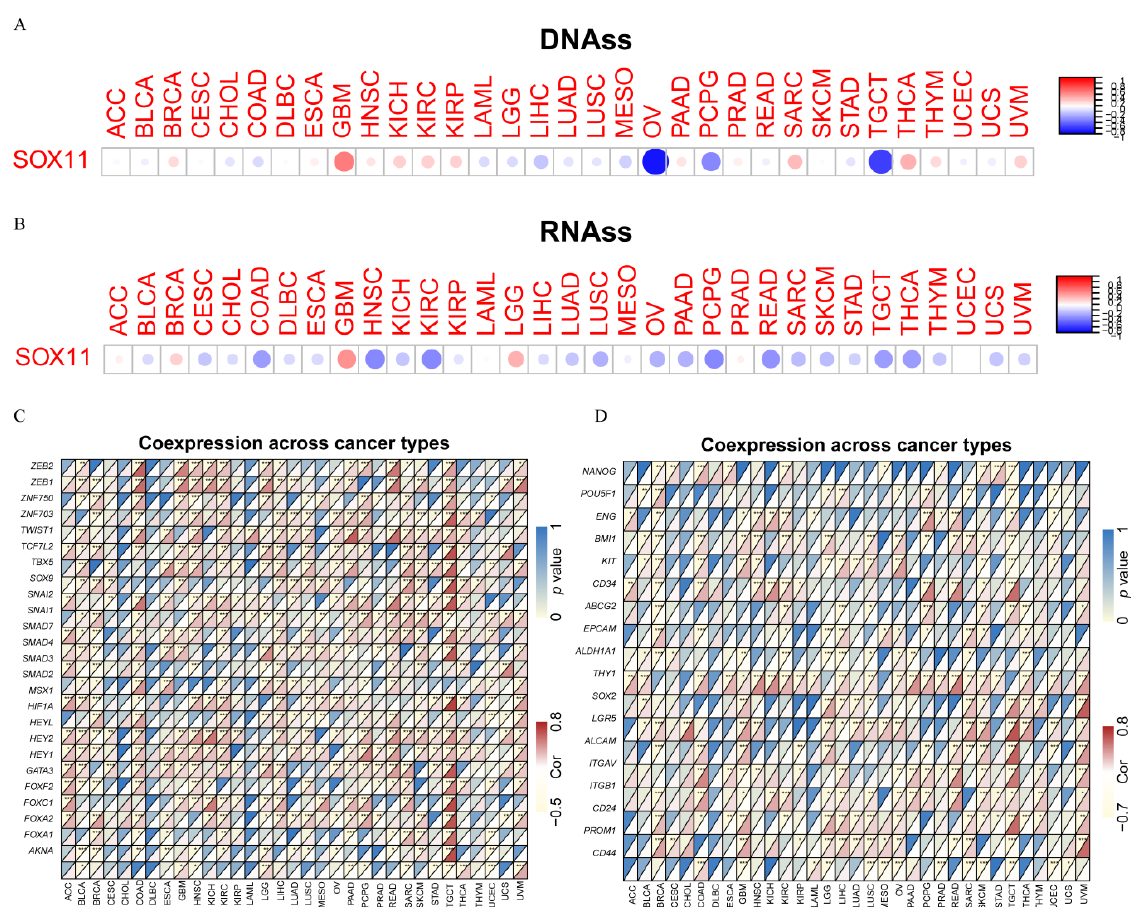
Figure 7. Analysis of the relationship between SOX11 expression and stemness and EMT-related genes in cancers. ( A ) The correlation between SOX11 expression and DNAss in different cancers. The red dots indicate positive correlations, while the blue dots denote negative correlations. DNAss, DNA stemness score ( B ) The correlation between SOX11 expression and RNAss in different cancers. RNAss, RNA stemness score ( C ) Correlation heatmap showing the relationship between SOX11 expression and EMT-related genes expression. For each pair, the top left triangle indicates the p- value, and the bottom right triangle denotes the correlation coefficient. ( D ) Correlation heatmap showing the relationship between SOX11 expression and cancer stem cell markers * p < 0.05, ** p < 0.01, and *** p < 0.001. Cor, correlation coefficient.